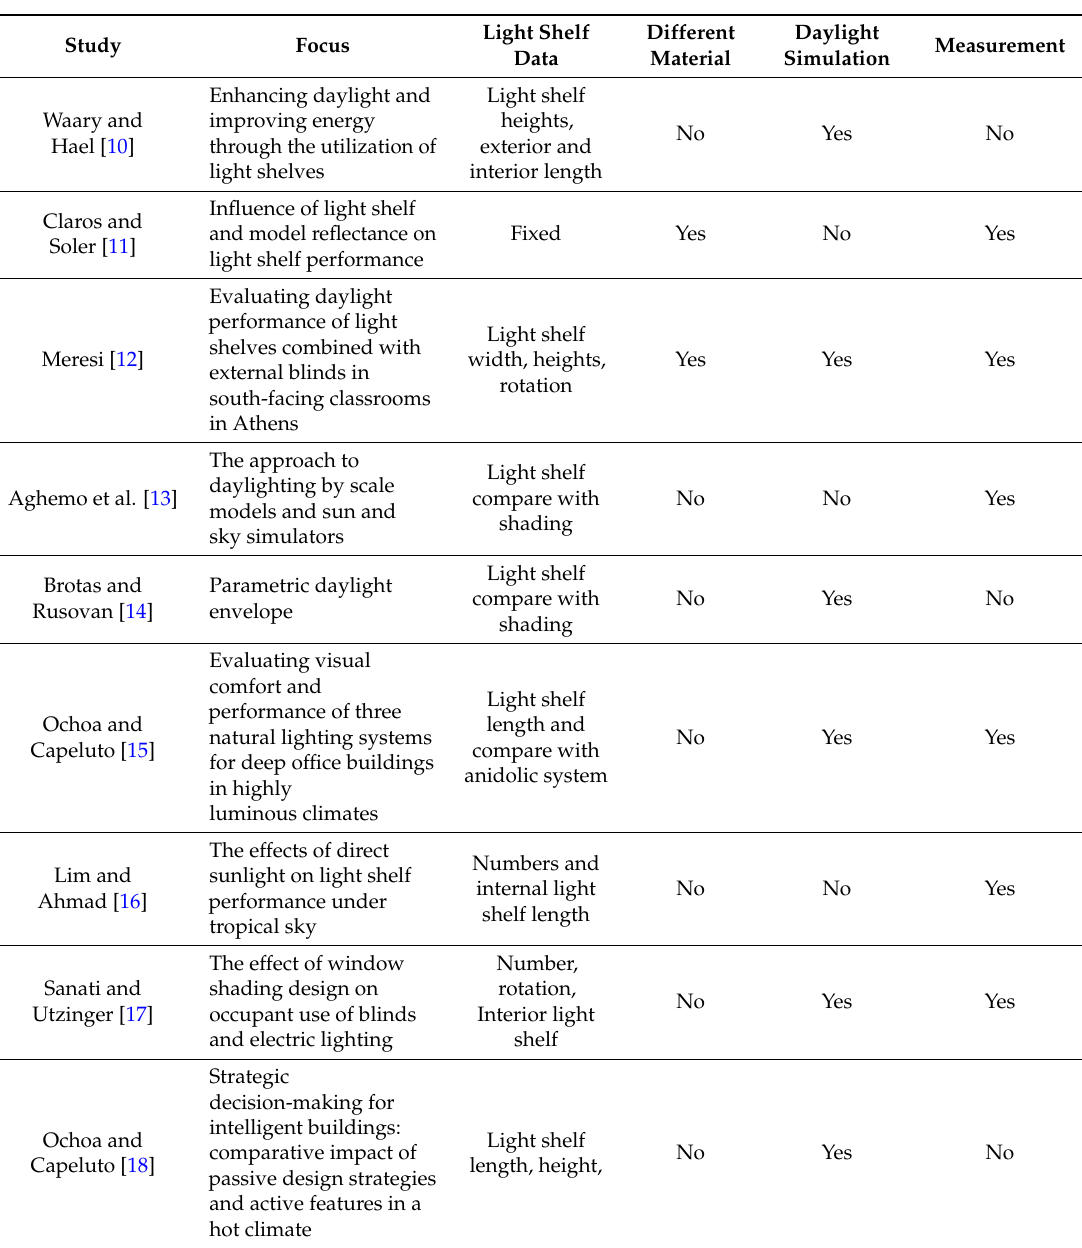
Table 1. Sample of conducted studies on the light